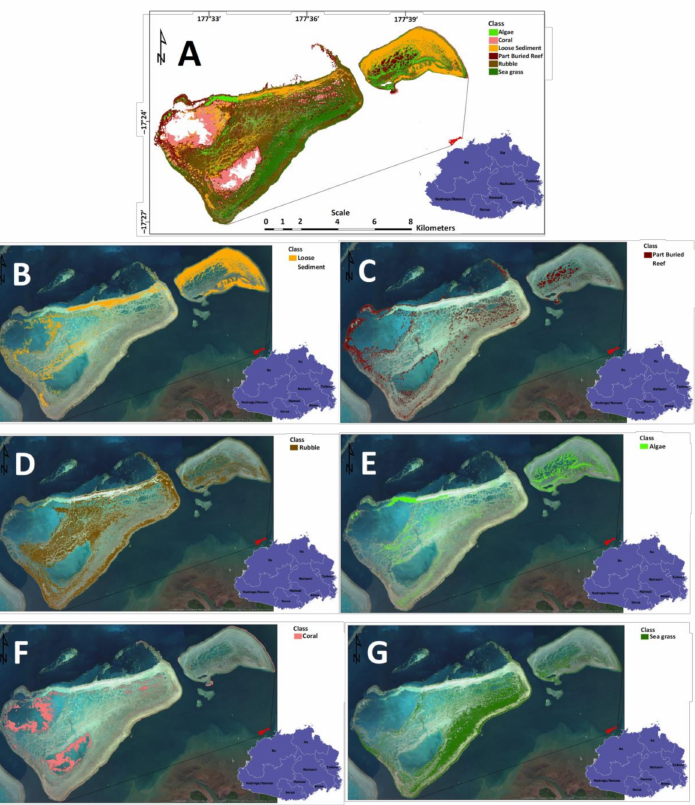
Figure 3. Six classes of habitat cover for the Cakaunisasi and Yarawa reefs of the Votua reef system, Ba, Fiji. Different letters show different attributes of the reef system benthic cover. ( A ) Overall benthic cover map showing six classes of habitat types and location, ( B ) sand and gravel, ( C ) buried reef, ( D ) coral rubble, ( E ) algae, ( F ) coral and ( G )